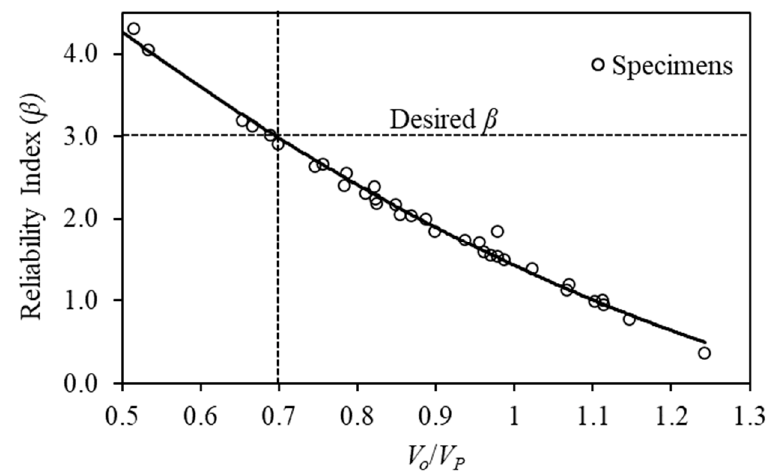
Figure 5. Effect of V 0 / V P on reliability indices of the specimens.